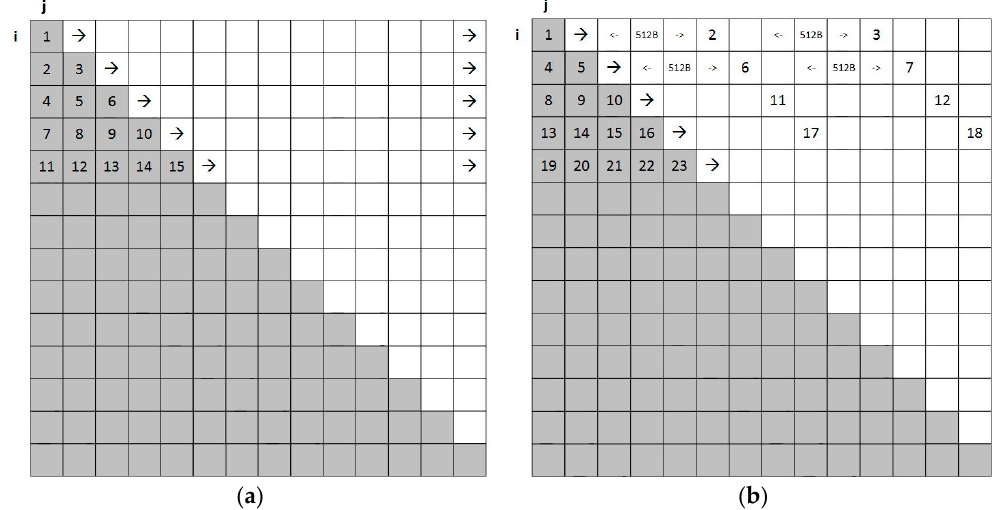
Figure 9. ( a ) Reading only the lower triangular matrix; ( b ) Reading the lower triangular matrix with 512 bytes address increments.